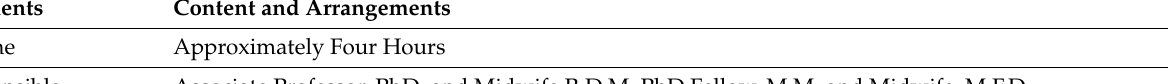
Table 1. Preliminary consultation plan,